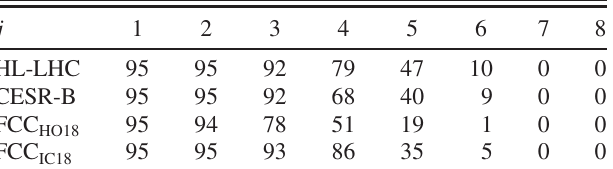
TABLE IV. The value in i th row, j th column is the number of distinct cavities that have at least j objectives better than the cavity which corresponds to row i . The last (60th) generation contains 95 distinct